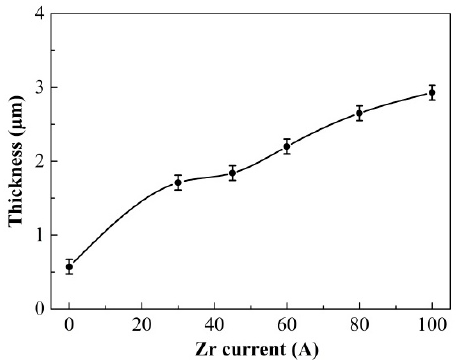
Figure 11. Coating thickness of the composite coatings.